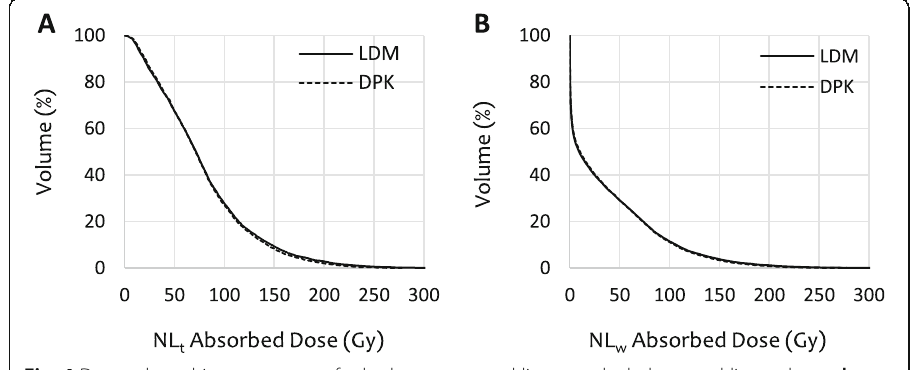
corresponding to patient 12. Continuous lines correspond to LDM method and the dashed lines to DPK method